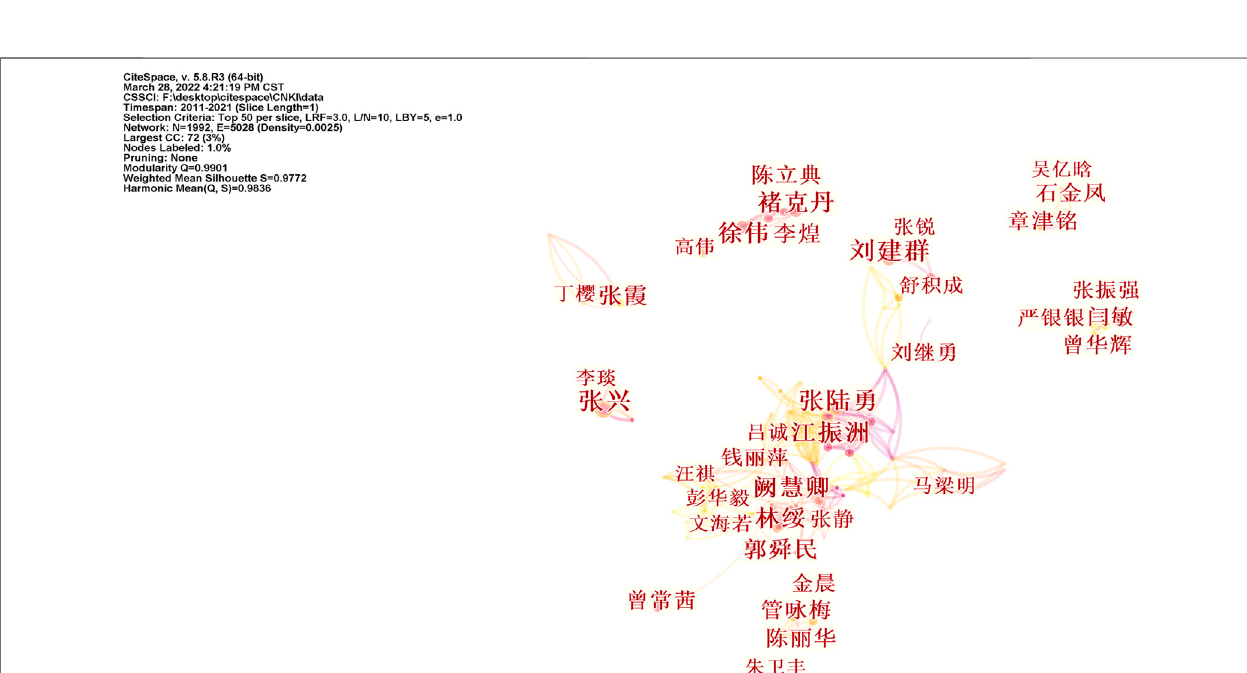
FIGURE 2 | Co-authorship network of triptolide literature keywords from the WOS.